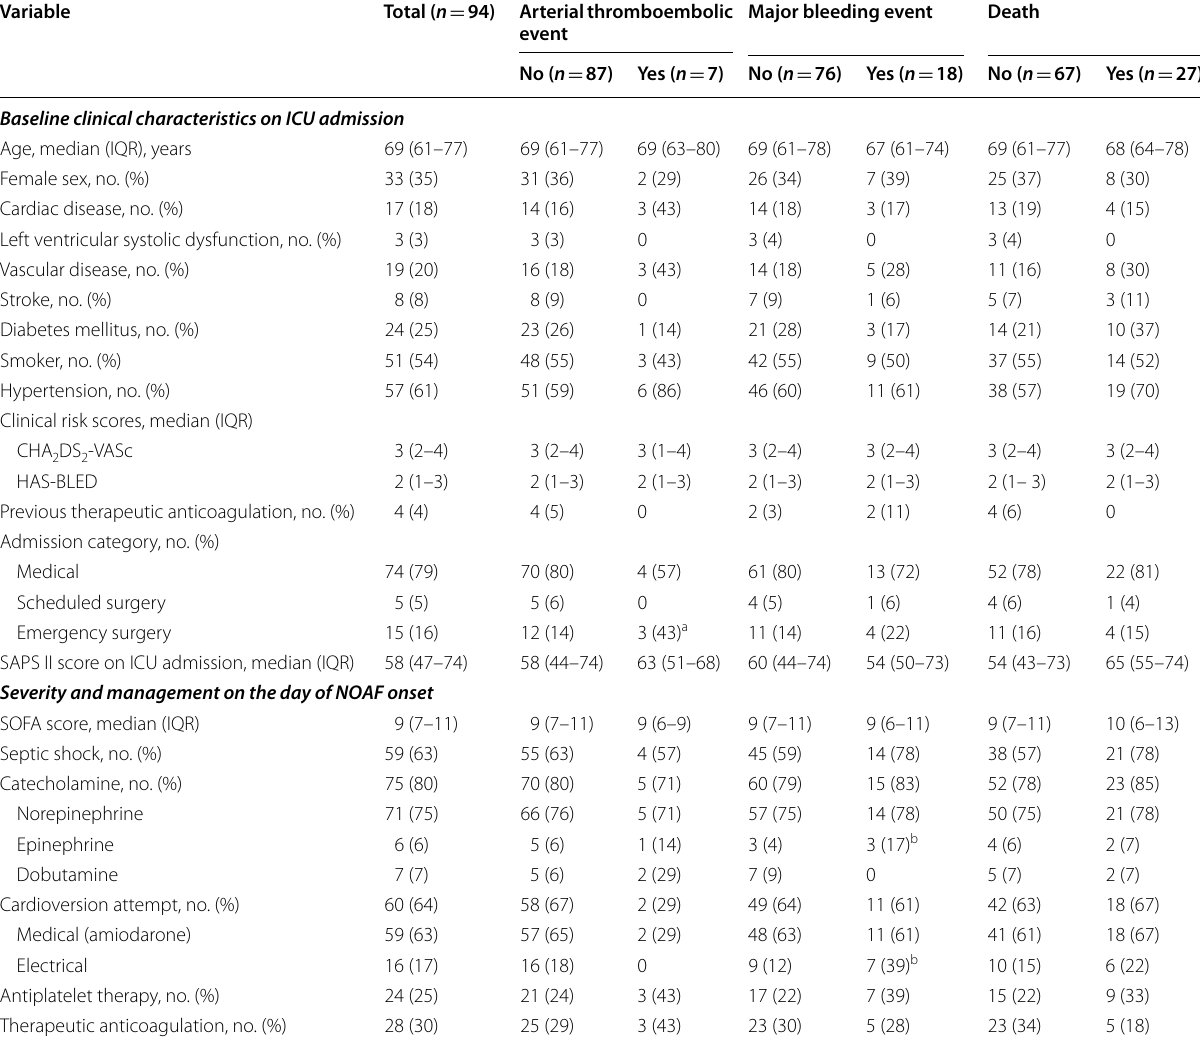
Table 1 Baseline clinical characteristics, initial severity, and initial new‑onset atrial fibrillation management according to 28‑day arterial thromboembolic events, major bleeding events and